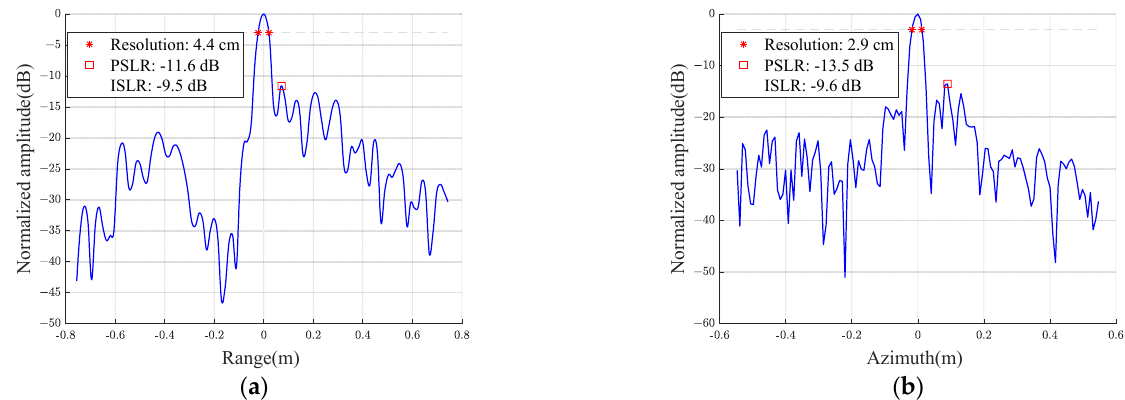
Figure 16. The profile of the trihedral reflector. ( a ) In range. ( b ) In azimuth. The measured values of the resolution, PSLR, and ISLR are listed in Table 2. It can be seen that the proposed SAR system has high resolution in range and azimuth. The ISLR of the system is slightly poor, which may be related to the waveform nonlinearity in the range and the unsatisfactory image focusing in azimuth. Table 2. Image quality assessment.